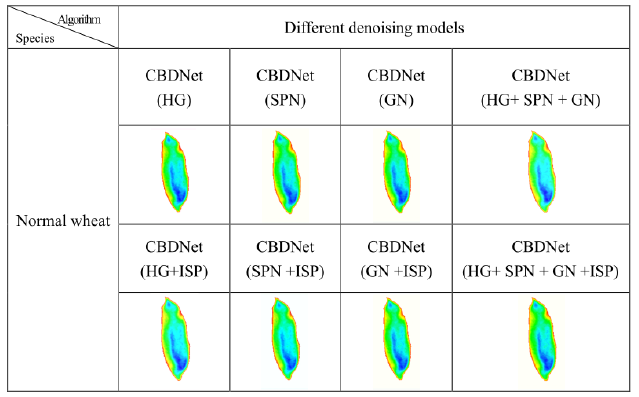
Figure 8. The comparison of the results of different noise models. Table 2. The PSNR/SSIM results for different noise